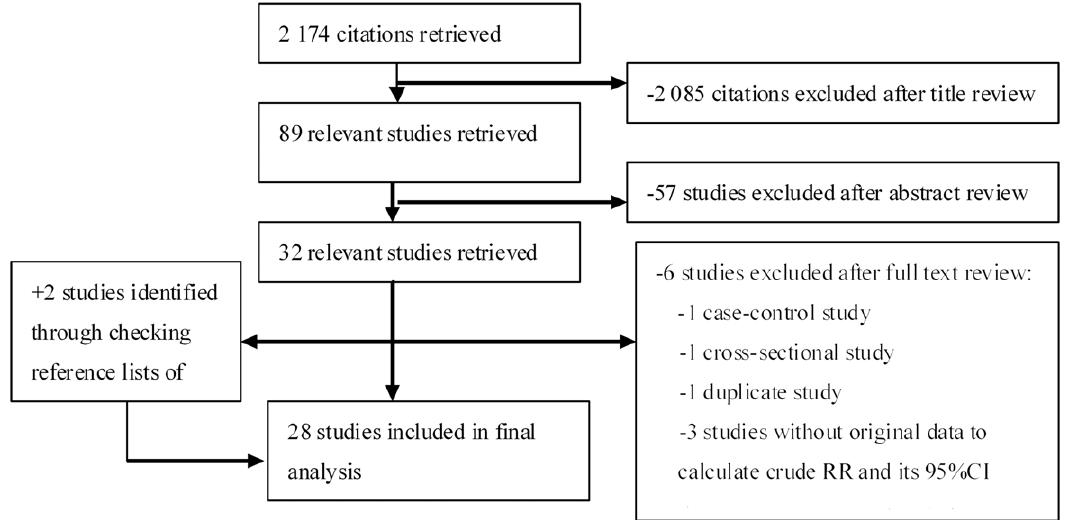
Figure 1. Selection of studies in the Meta-analysis.